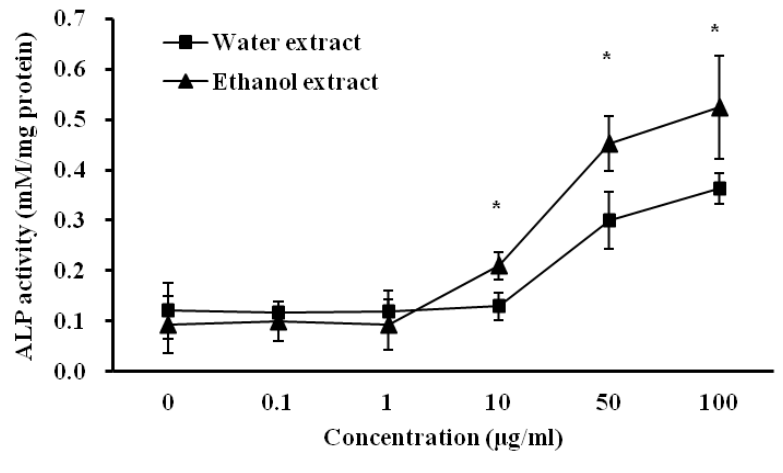
Figure 5. Effects of water and ethanol extracts from Drynariae rhizoma on the alkaline phosphatase of mouse osteoblastic cells. Cells were treated with vehicle or various concentrations of D. rhizoma extracts for 96 h. Each point represents the Mean ± SD. Significant differences were compared with vehicle control ( p <